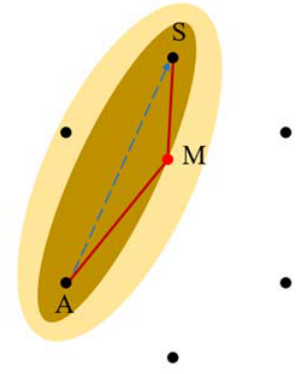
Figure 4. The probability imaging diagram.